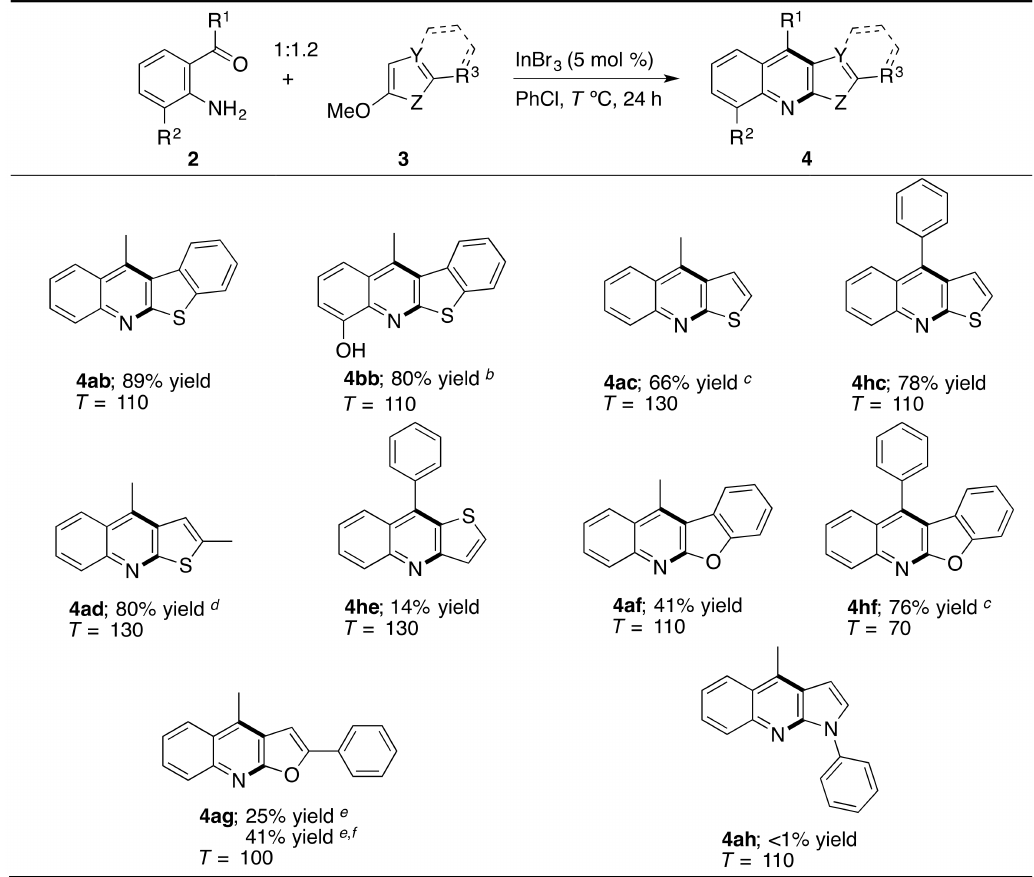
Table 4. Indium-catalyzed annulation of o -acylanilines with methoxyheteroarenes a .